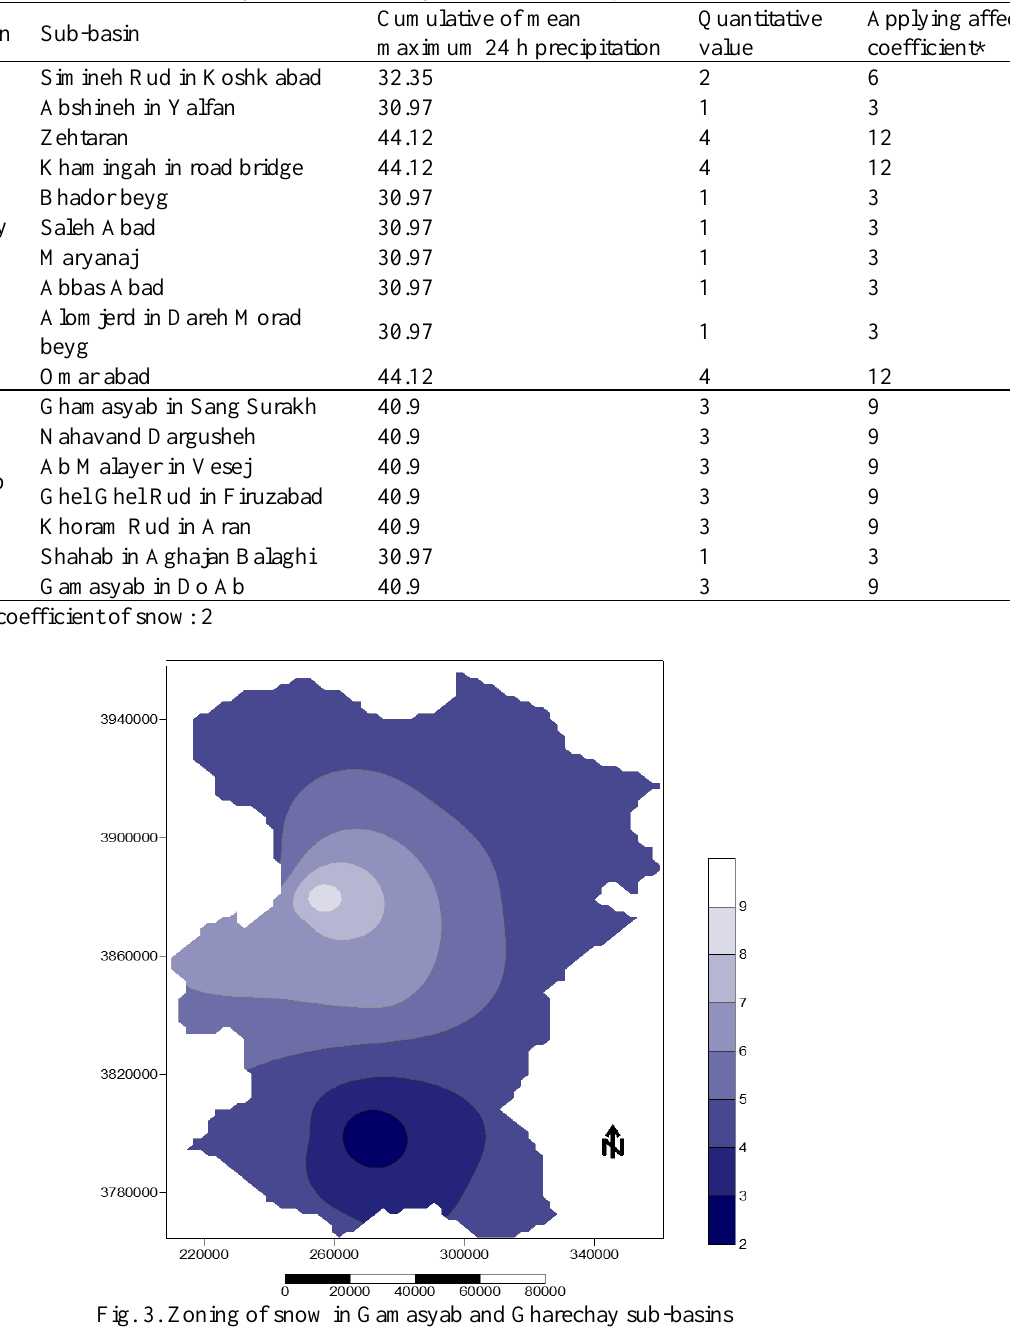
Cumulative of mean maximum 24 h precipitation